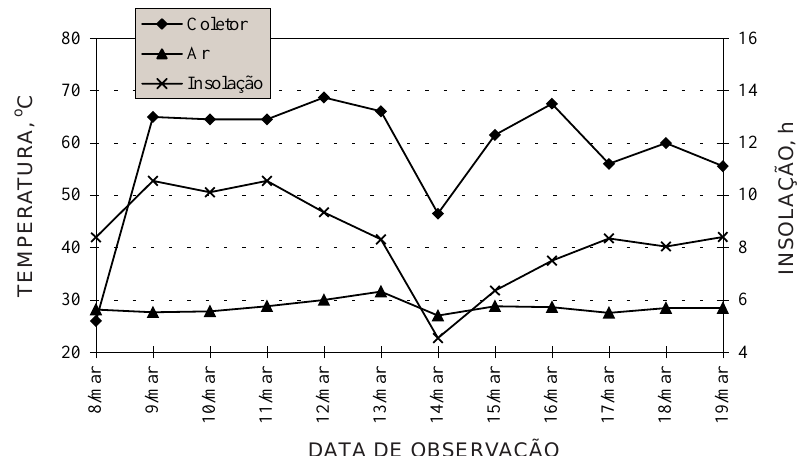
Figura 2. Temperaturas máximas do ar e do solo no coletor solar e horas diárias de insolação no período de 8 a 19 de março de